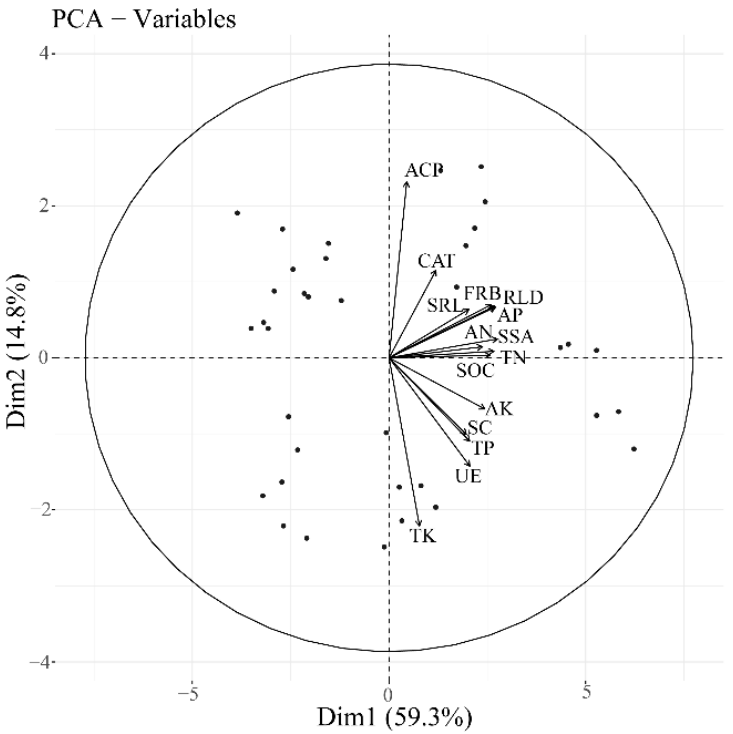
Figure 5. Principal component analysis of variables. The arrow line of the variables is plotted as the correlation coefficients between them and the first two principal components in the unit circle; the length of the arrow line indicates the contribution of the variable. Table 3. Principal component analysis contribution rate of variables.